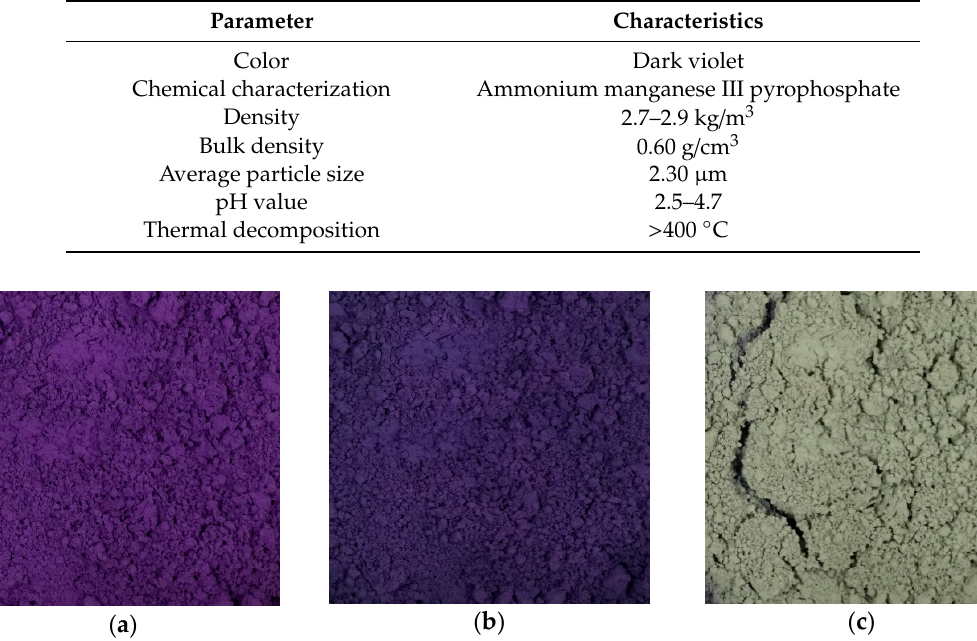
Table 1. Typical characteristics of MnNH 4 P 2 O 7 pigment [26].